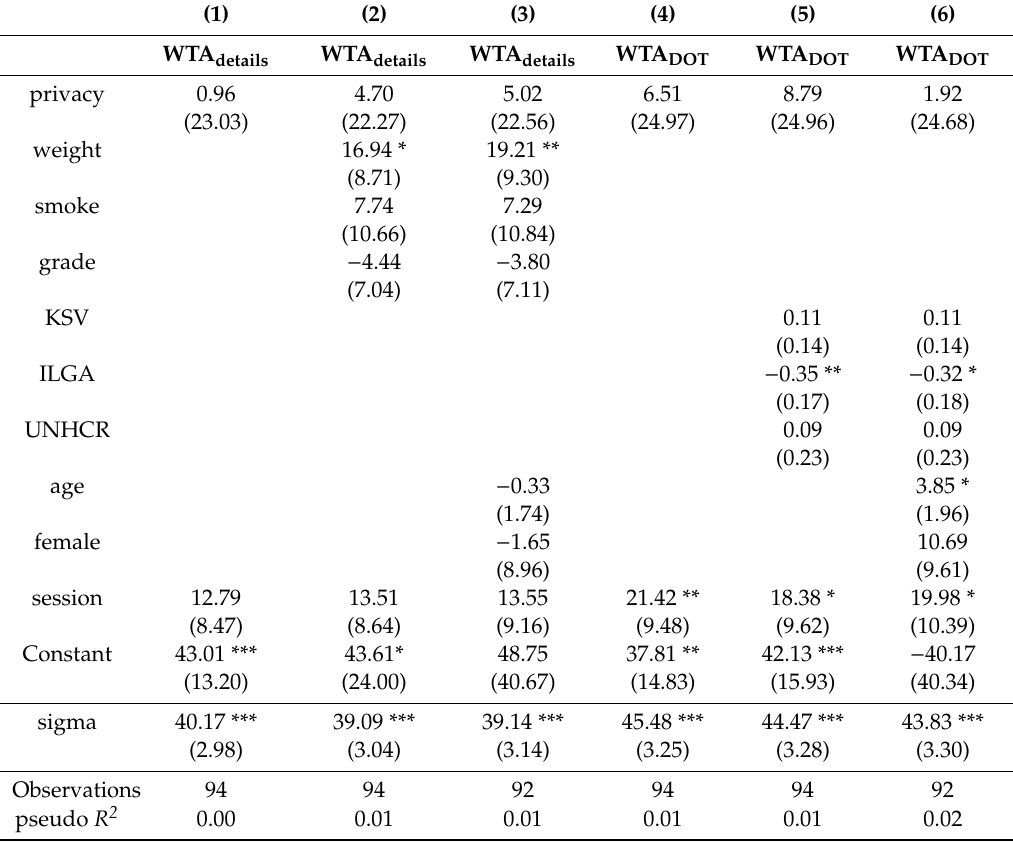
Table A5. Tobit regressions of WTA on self-stated privacy behavior (factor analysis a1-a7) and information at